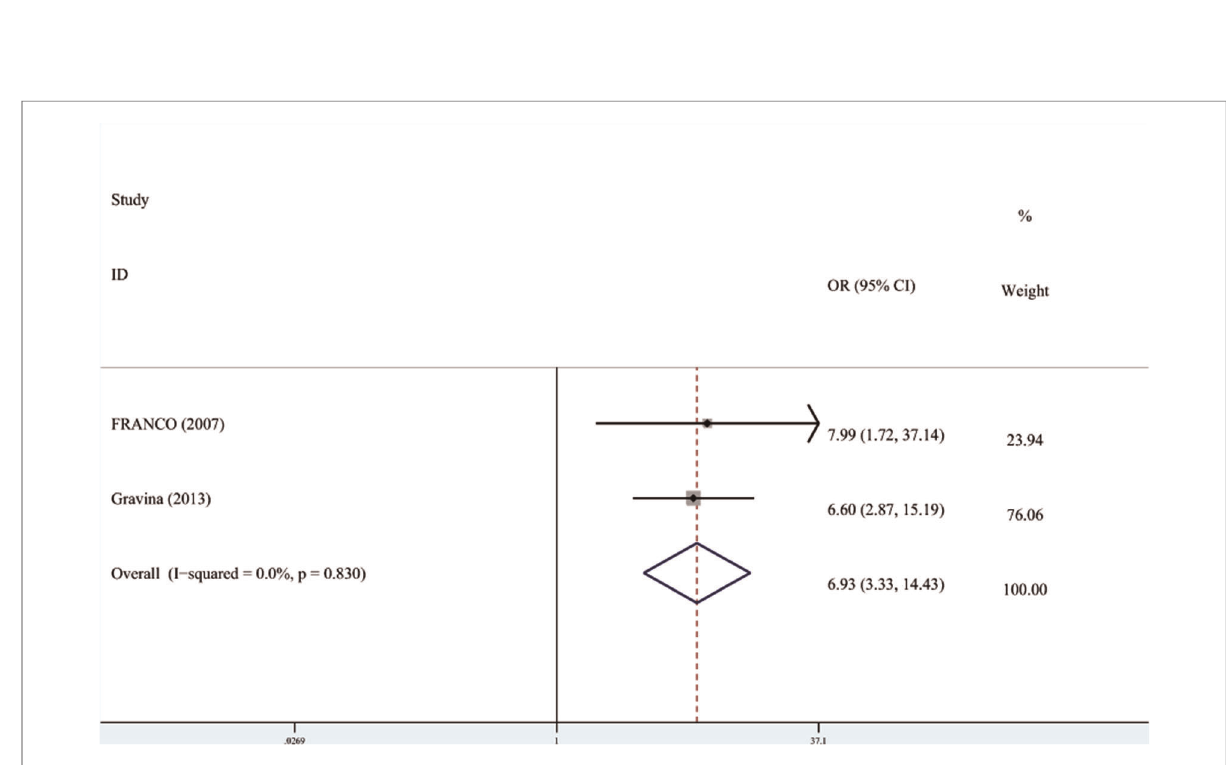
FIGURE 5 The forest plot shows the relationship between PT and EHP (FEM). PT, preterm; EHP, enamel